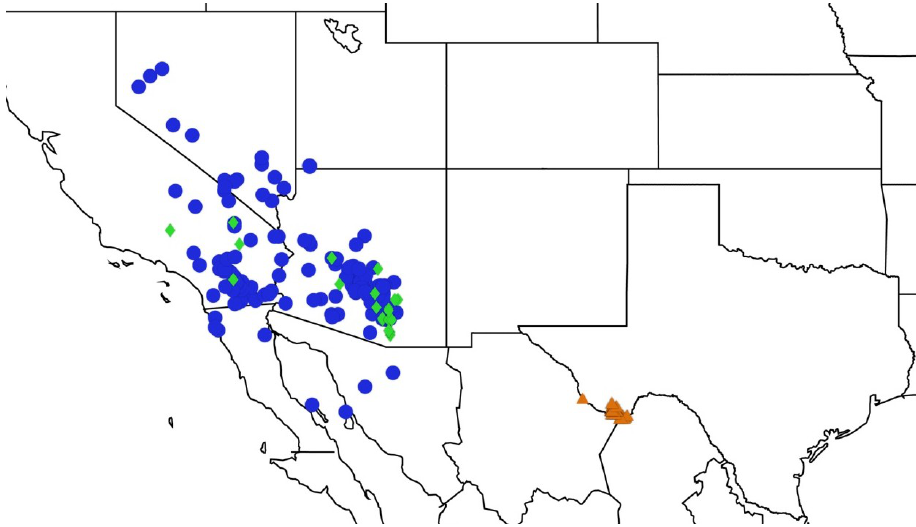
Figure 64. Distribution of Okanagodes gracilis gracilis (blue circles), O. gracilis viridis (green diamonds) and O. terlingua (orange